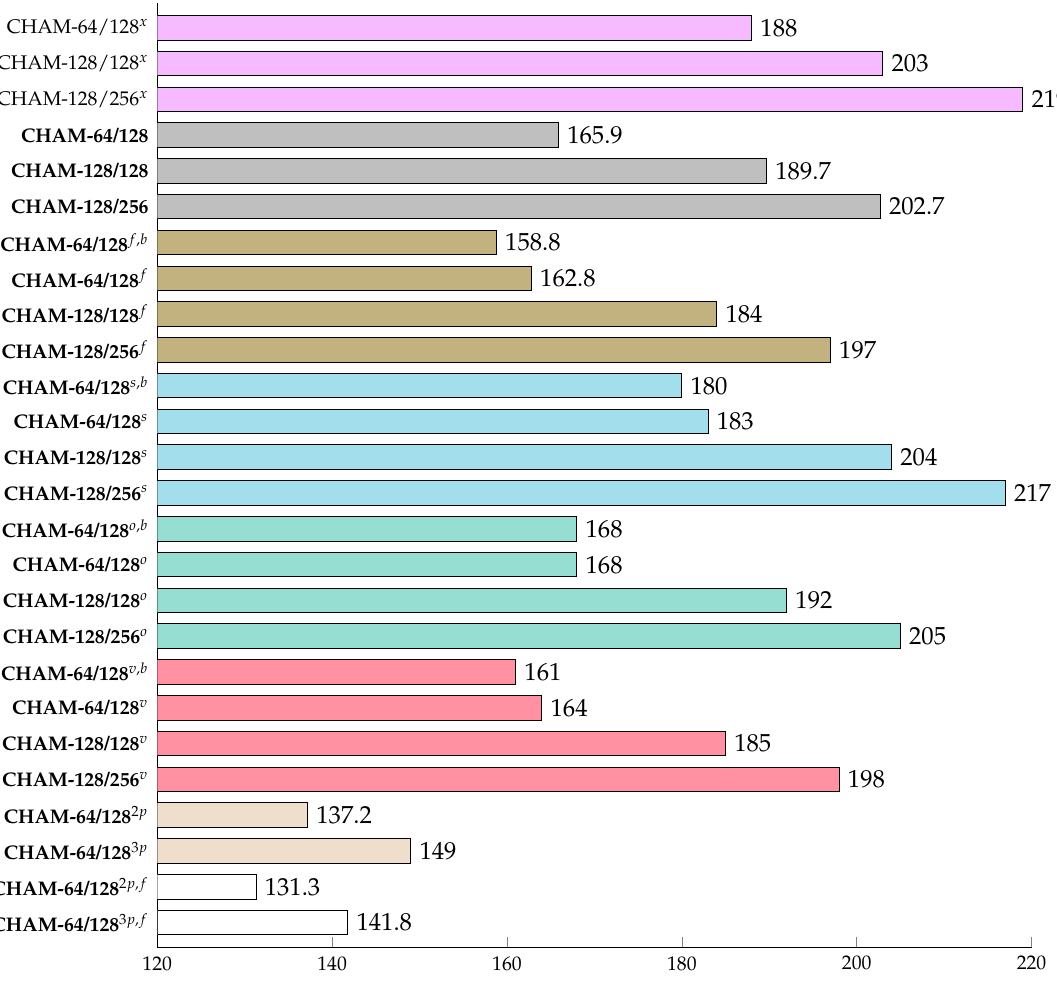
Figure 7. Comparison of execution time for CHAM implementations on 8-Bit AVR microcontrollers under the fixed-key scenario in terms of clock cycles per byte, b : 16-bit counter for